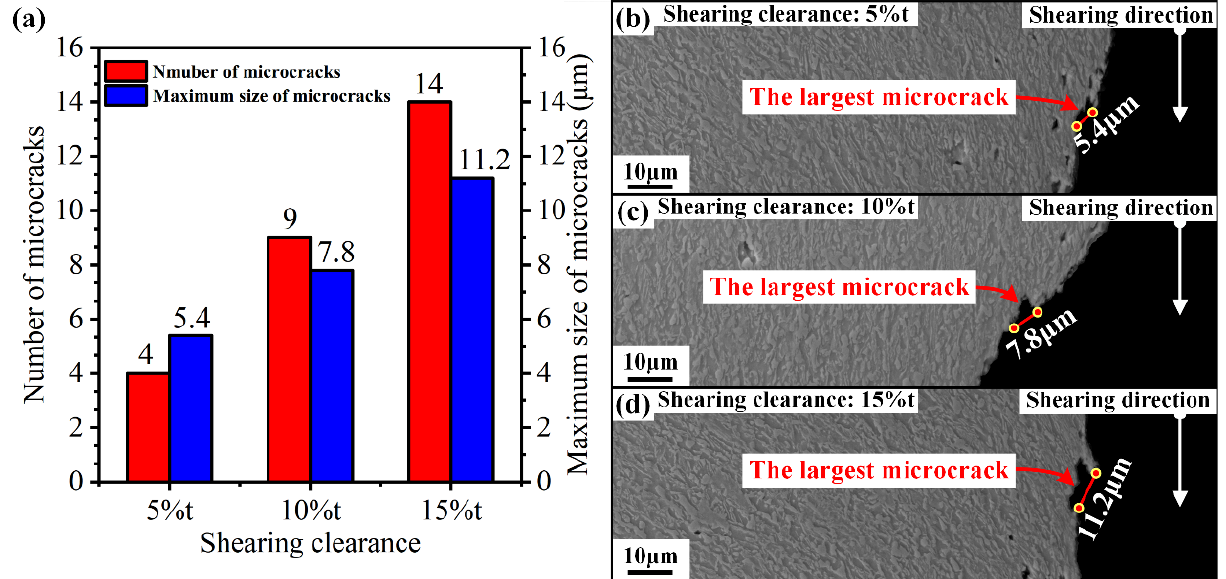
Figure 20. ( a ) Number and size of microvoids generated in the sheared edge. ( b ) largest microcrack obtained under the shearing clearances of 5%t, ( c ) 10%t, ( d ) 15%t.